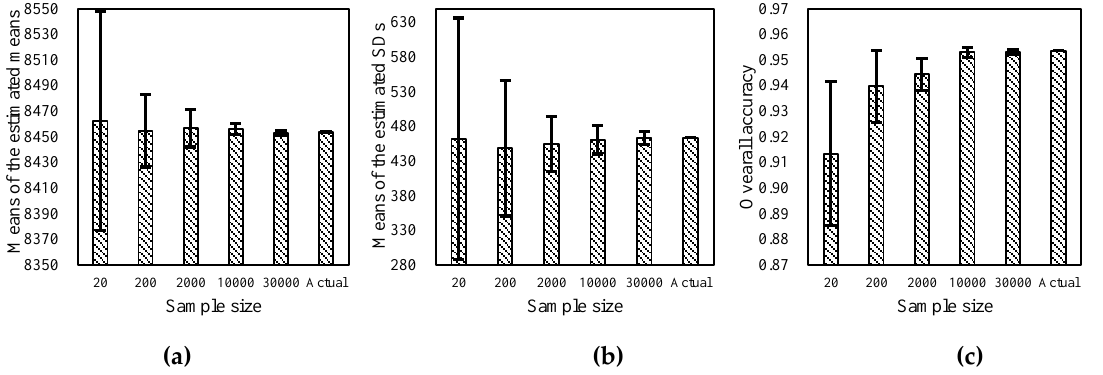
Figure 14. Impact of sample size on the mean ( a ) and standard deviation ( b ) estimation (NDVI of soybean in Landsat image of DOY 219) and ( c ) the classification accuracy. The actual values are calculated from all soybean pixels.